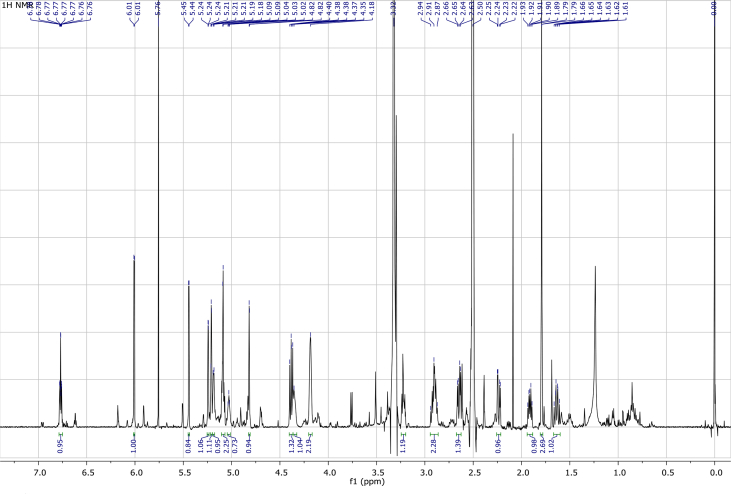
1H NMR (DMSO-d6) spectrum of compound 13.